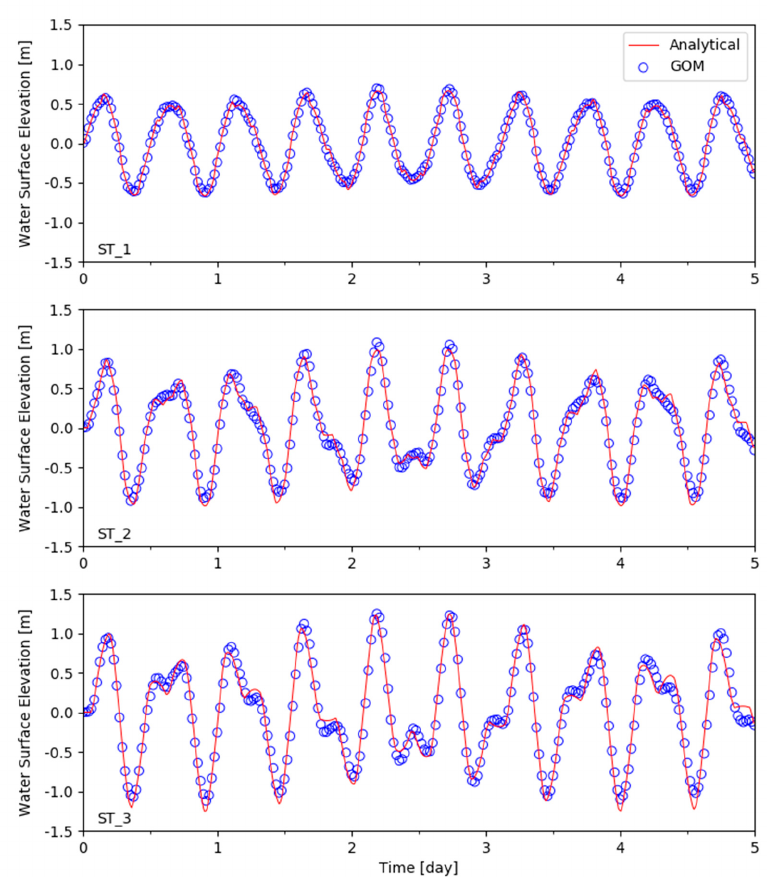
Figure 10. Comparison of water surface elevation for the tidal propagation test at three different locations with 𝜃 = 0.5 . Solid lines and circles represent analytical solutions and numerical results, respectively. ST_1, ST_2, and ST_3 denote result extraction locations shown in Figure 8.